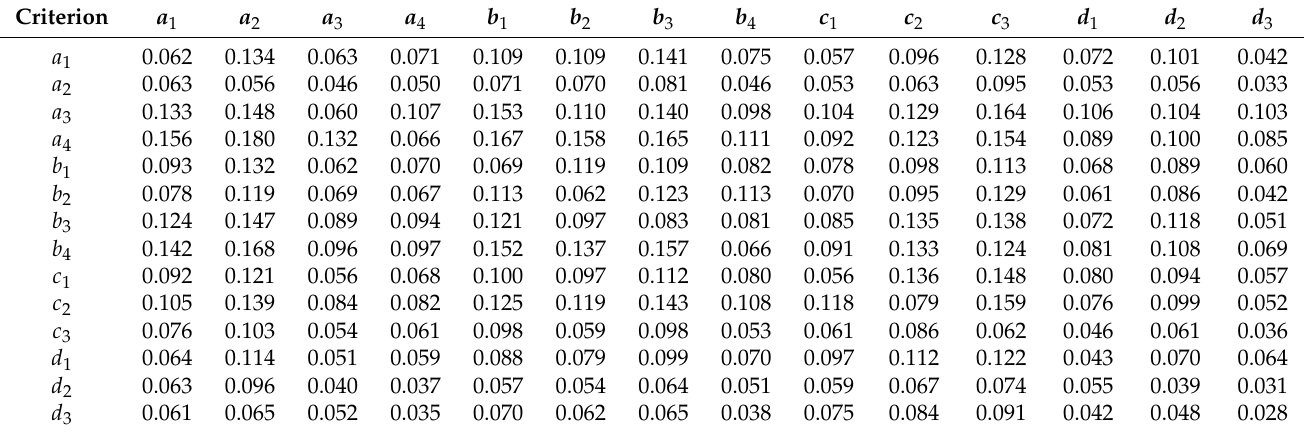
Table 6. Fuzzy normalized direct and indirect influence relation matrix T m (medium).